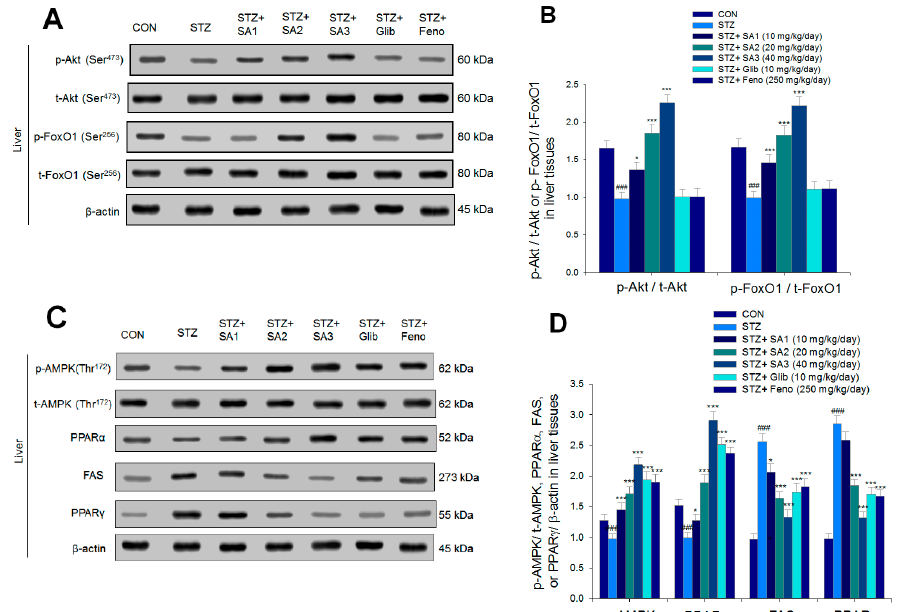
Figure 7. The expression levels of ( A ) p-Akt (Ser 473 )/t-Akt (Ser 473 ) and p-FoxO1 (Ser 256 )/t-FoxO1 (Ser 256 ),